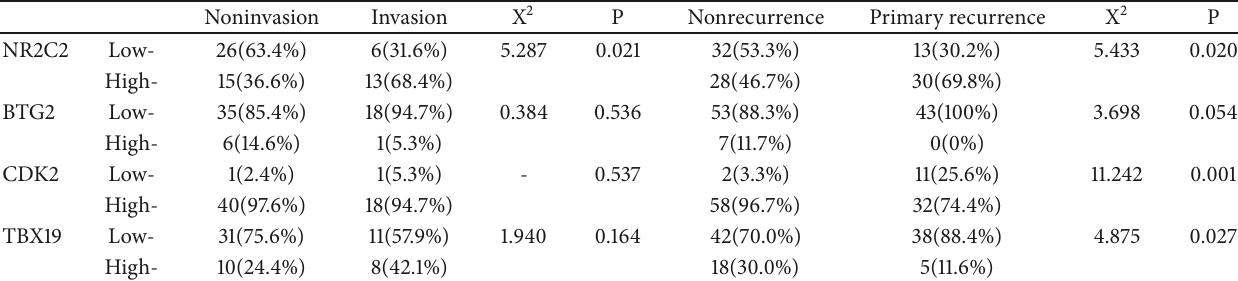
Table 2: Noninvasion group versus invasion group and nonrecurrent group versus primary recurrent